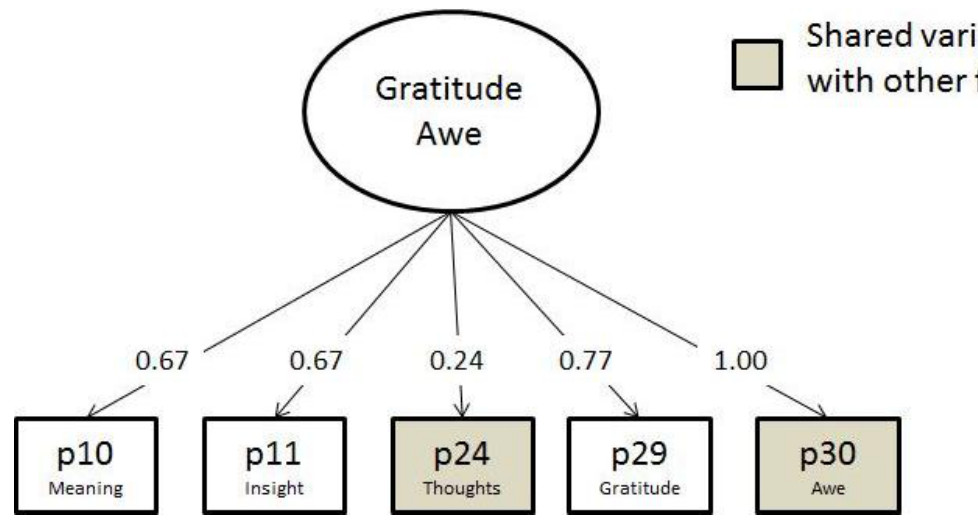
Figure 4. Factor Gratitude/Awe from SEM.